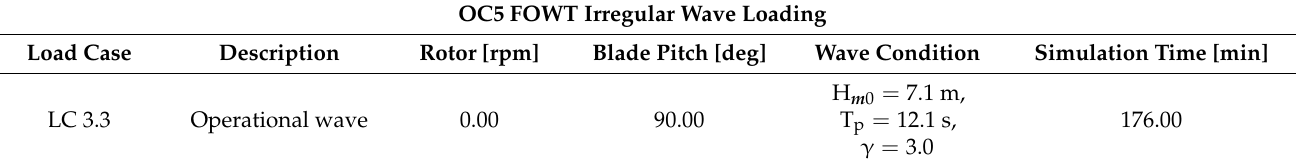
Table 2. FOWT irregular wave-only load case. OC5 FOWT Irregular Wave